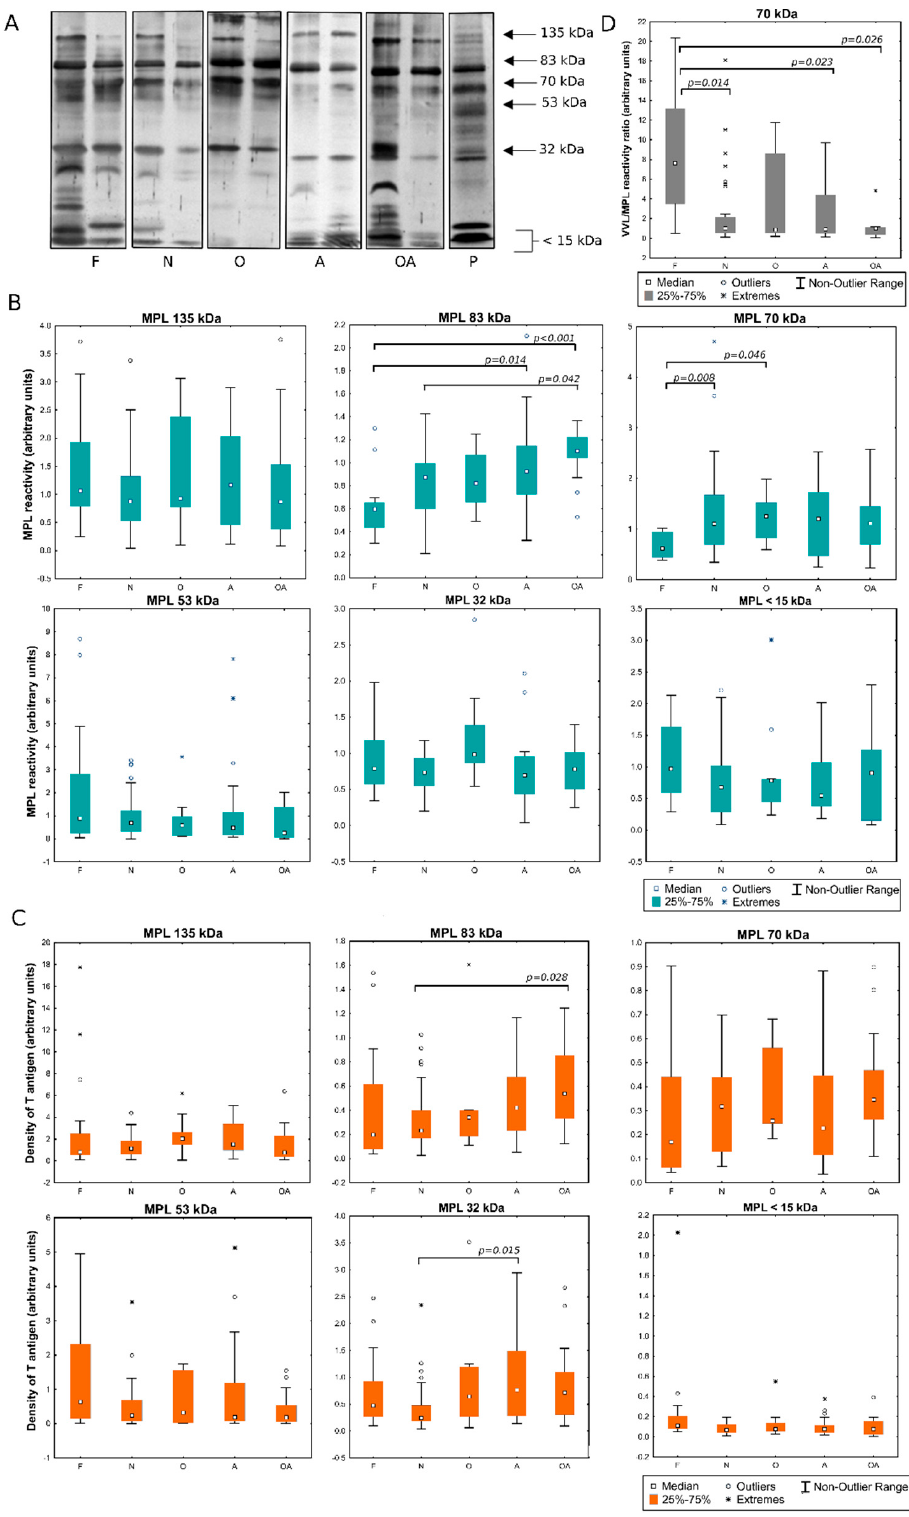
Figure 3. Maclura pomifera reactivity of seminal plasma. ( A )—representative lectin-blotting patterns of individual samples classified to different diagnostic groups: F: normozoospermic fertile (control); N: normozoospermic non-fertile; O: oligozoospermic; A: asthenozoospermic; OA: oligoasthenozoospermic; P: SDS-PAGE seminal plasma protein bands stained with SyproRuby (negative); ( B )—total reactivity in the selected bands measured as densitometric analysis; ( C )—density of MPL-detected glycans calculated as MPL/protein ratio; ( D )—lectin reactivity ratio of VVL to MPL for the 70 kDa